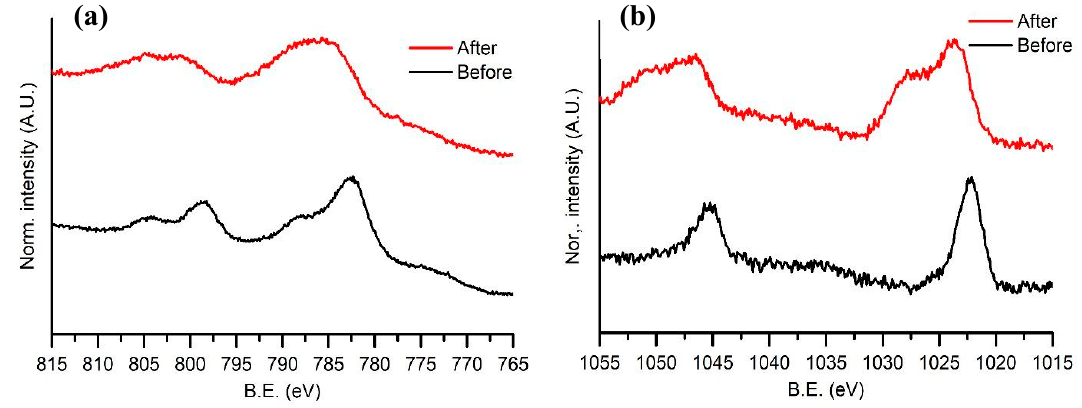
Figure 7. ( a ) High-resolution XPS for the Co 2p peaks in the range 815–765 eV. ( b ) High-resolution XPS for the Zn 2p peaks in the range 1055–1015 eV.